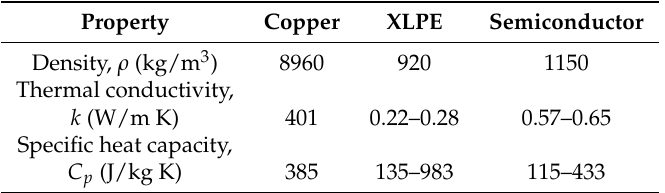
Table 1. Properties of cable materials for heat transfer analysis